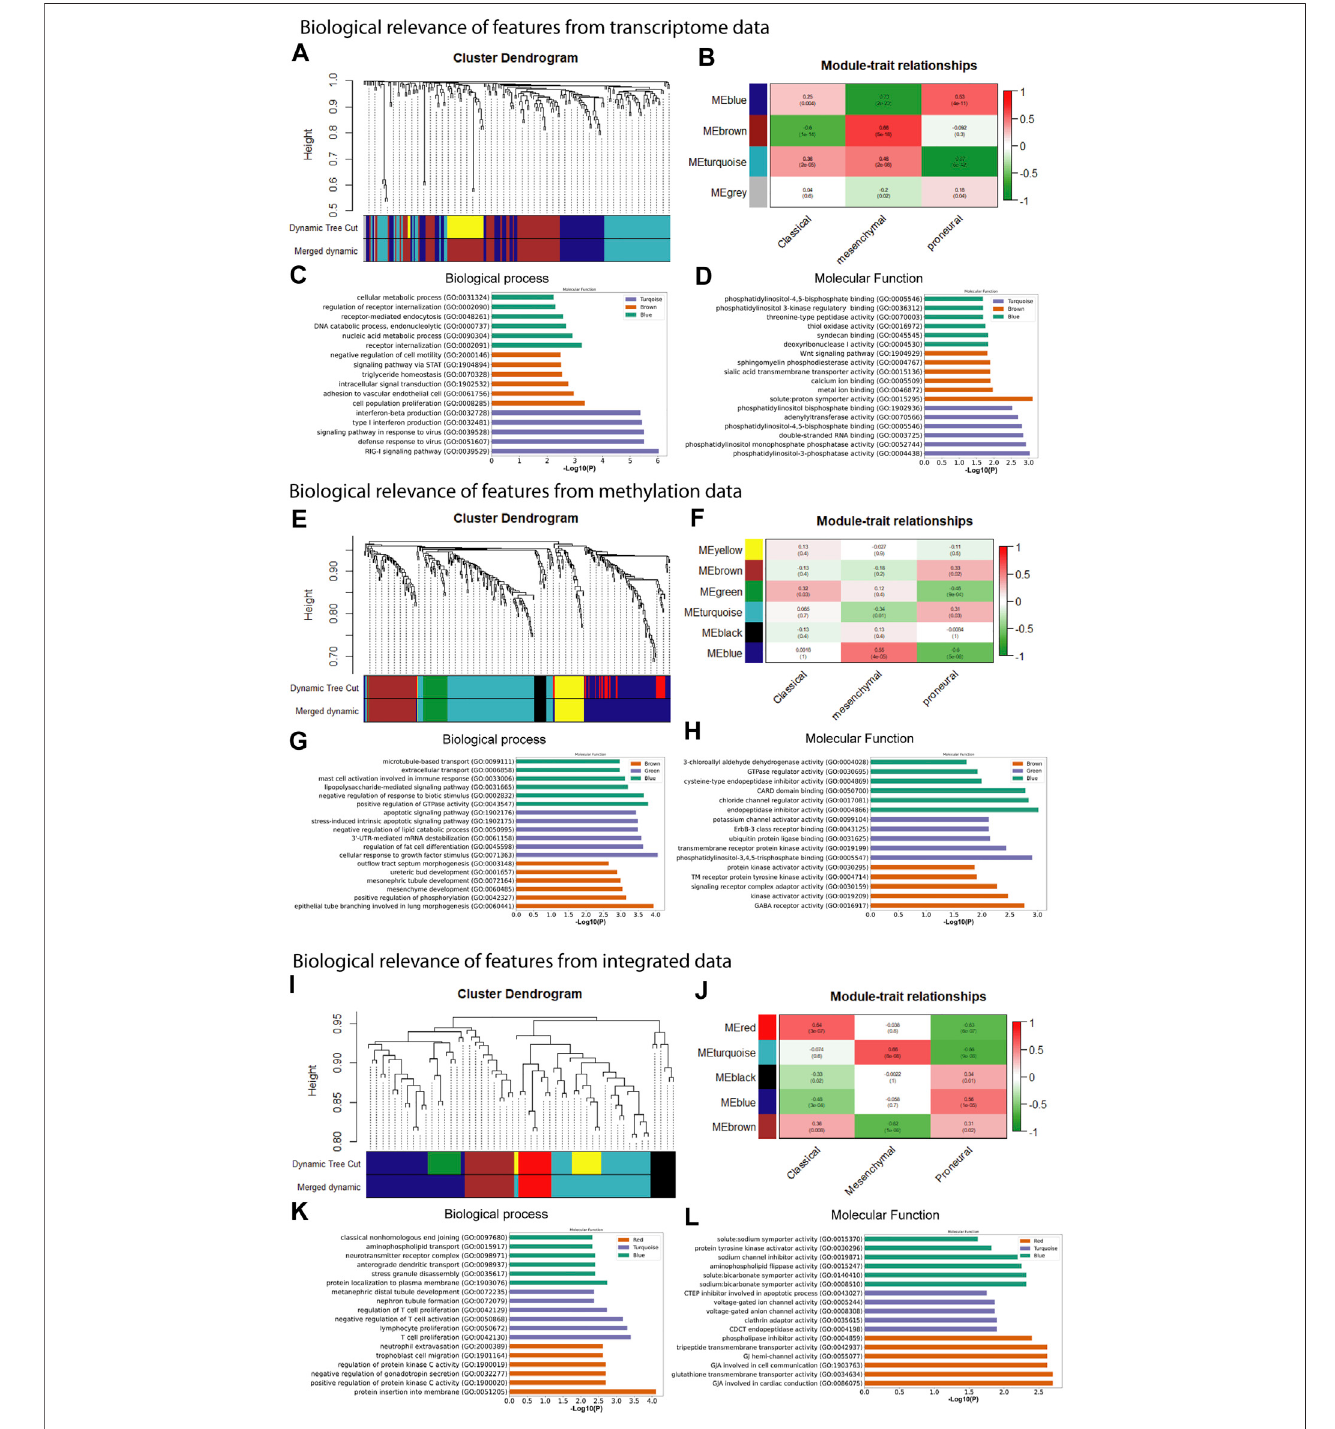
FIGURE 4 | Weighted gene co-expression network analysis and gene set enrichment of feature used for model building. (A) co-expression gene module, (B) module-trait relationship, (C) biological process, and (D) molecular function of feature from transcriptome data. (E) co-expression gene module, (F) module-trait relationship, (G) biological process, and (H) molecular function of feature from methylome data. (I) co-expression gene module, (J) module-trait relationship, (K) GO biological process term analysis, and (L) GO molecular function of feature from integrated data.